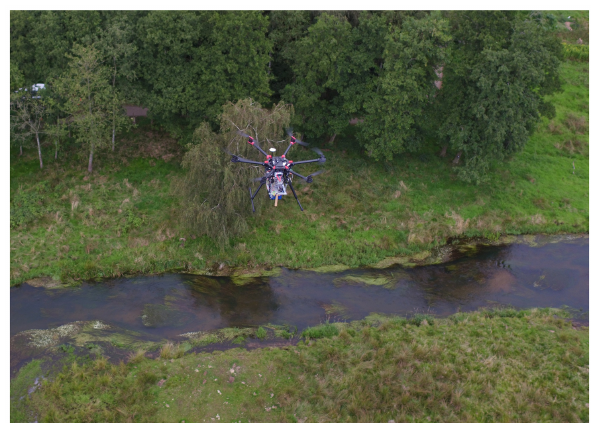
Figure 4. Flow measurements using a drone. Flight campaign by Sune Yde Nielsen, Henrik Karmisholt Grosen (Drone Sys- tems.DK), Christian Josef Köppl and Filippo Bandini (DTU En-